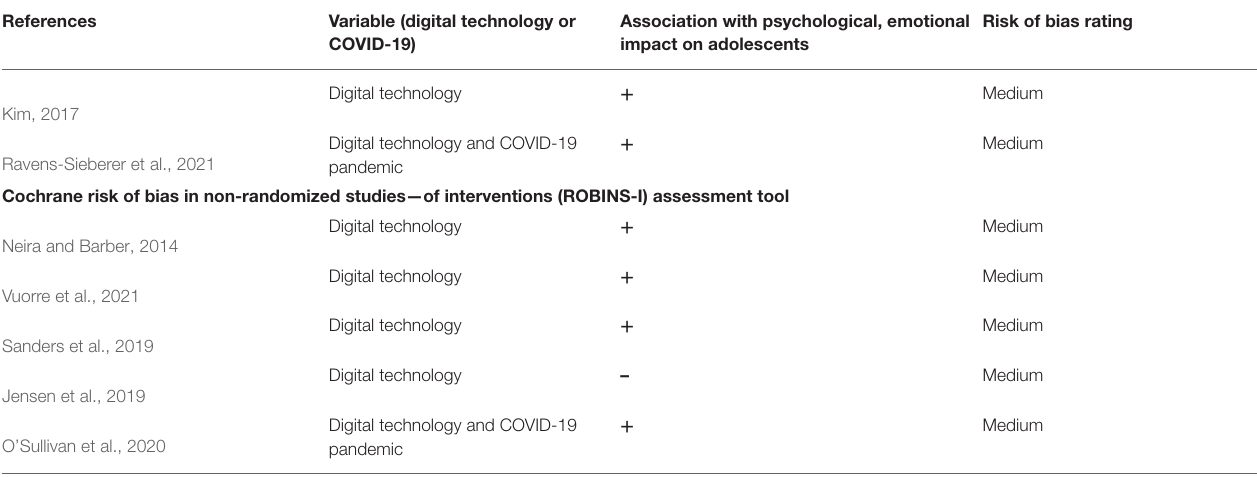
Table includes study scores for risk of bias quality criteria as per the AHRQ tool for healthcare research and the ROBINS-I tool for non-randomized clinical trial studies. + increase in variable found; x no significant association found; – decrease in variable found; Medium = Study judged to raise some quality concerns in at least one domain but not to be at high risk of bias for any domain for